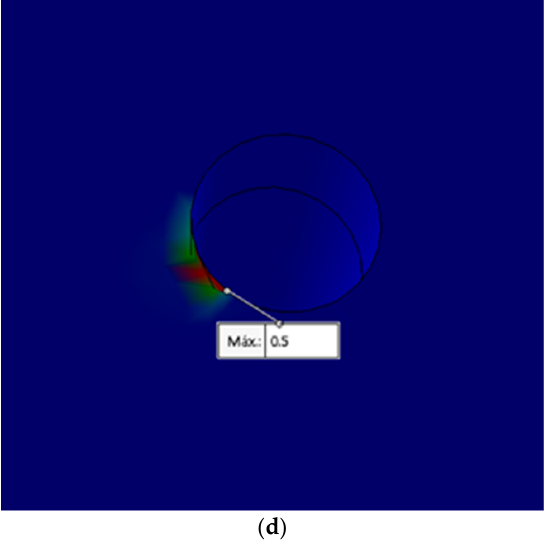
Figure A5. Maximun stress in the bone with 150 N: ( a ) Internal hexagon; ( b ) morse taper; ( c ) conical connection; ( d ) conical triangular connection.